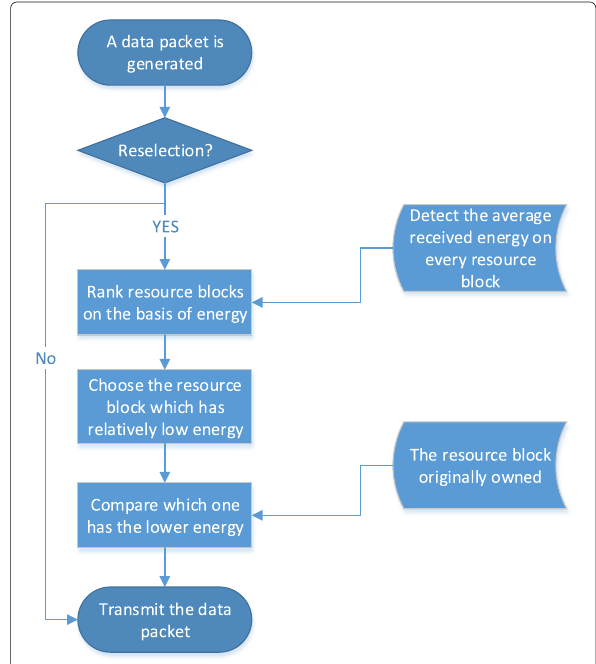
Fig. 4 Demonstration of every step in the process of sensing